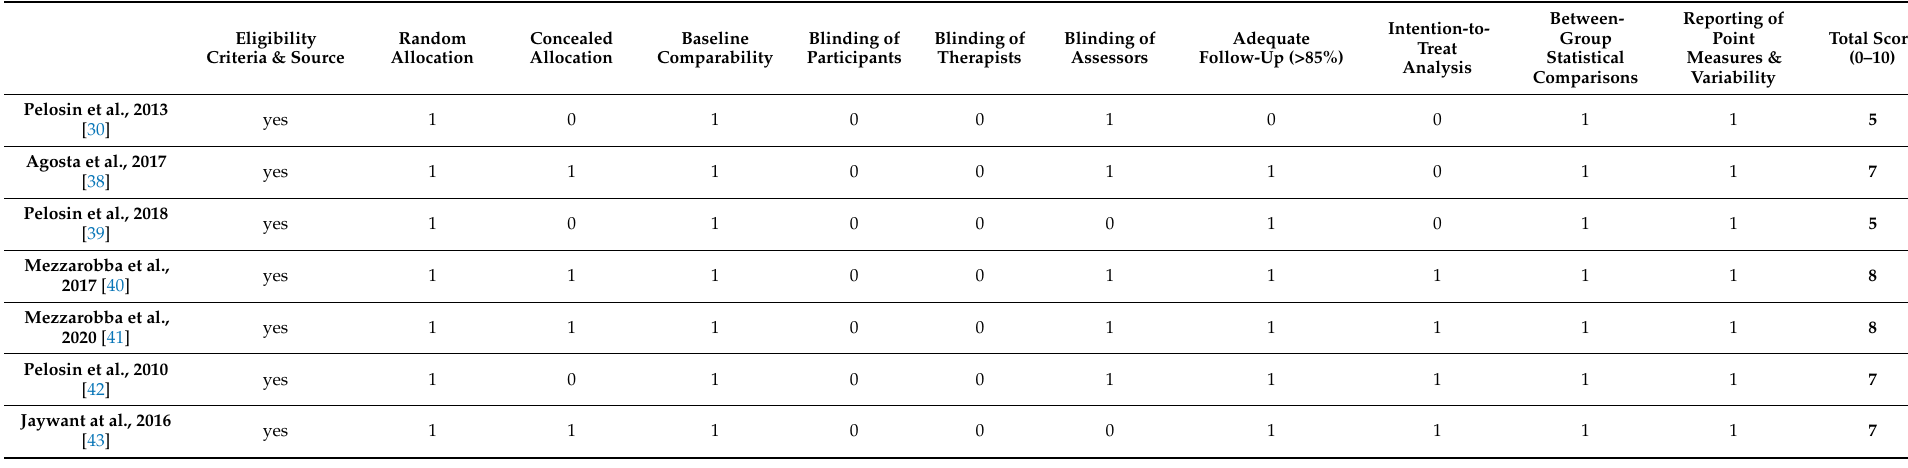
Table 2. Risk of bias in the included studies.